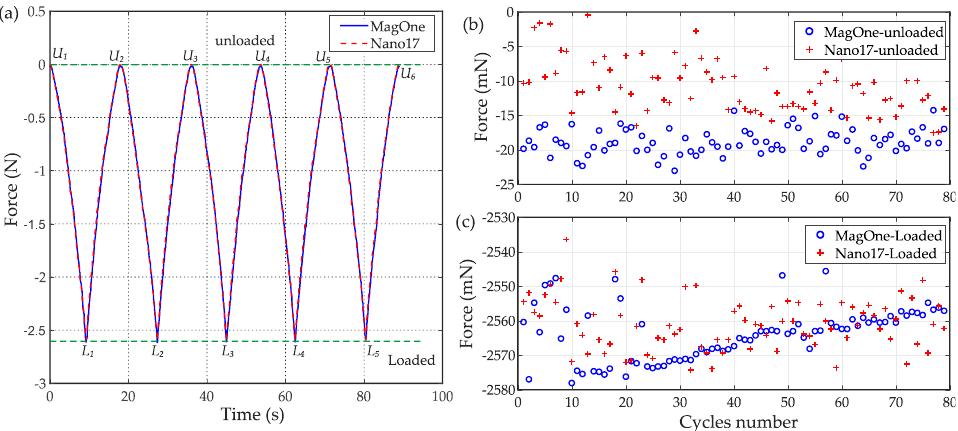
Figure 14. ( a ) Five cycles of the indentation test result; ( b ) Unloaded force output of MagOne and Nano17 for 80 cycles of indentation test; ( c ) Loaded force output (same as ( b )).